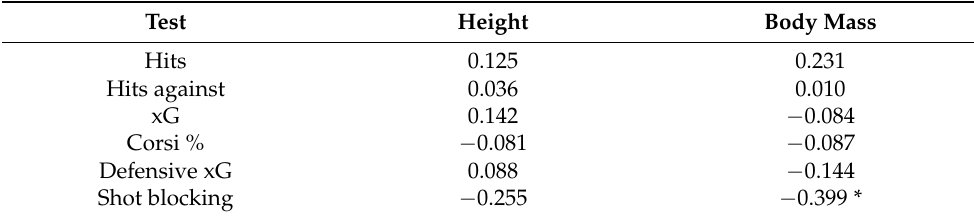
Table 5. Associations between anthropometry and match performance indicators (InStats) .